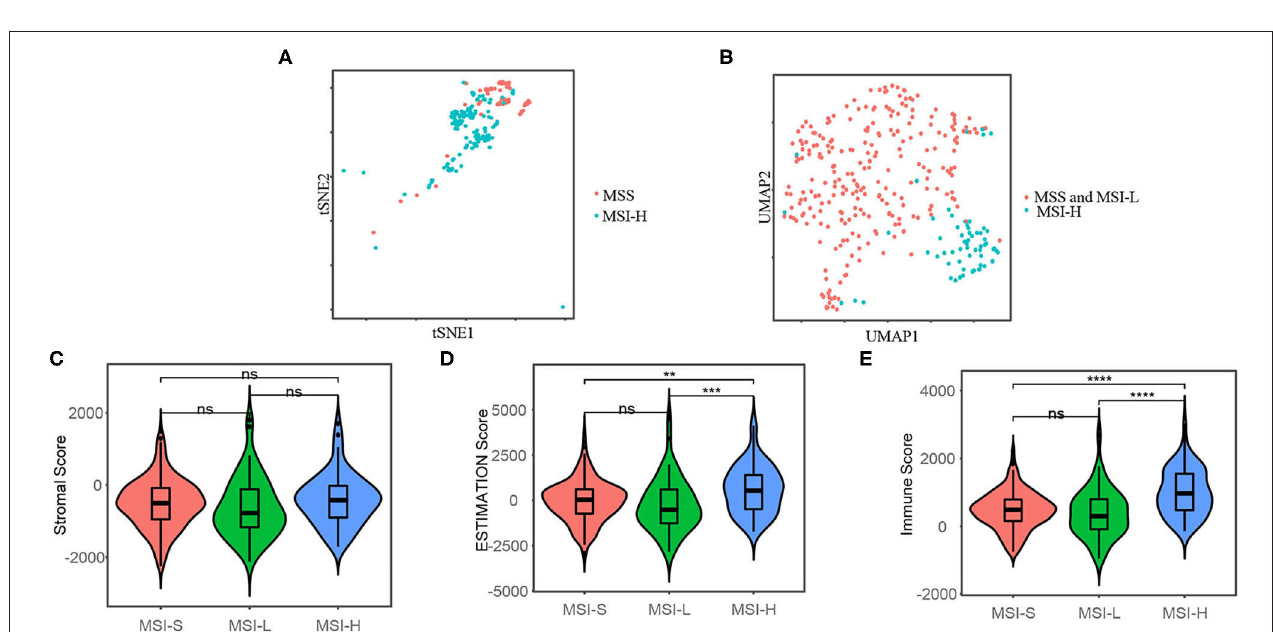
FIGURE 2 | t-distributed stochastic neighbor embedding (t-SNE) plot (A) shows that the microsatellite instability-high (MSI-H) and microsatellite stability (MSS) colon cancer cells are clustered differentially by single-cell RNA sequencing (RNA-seq) data from GSE146771 and uniform manifold approximation and projection (UMAP) plot (B) shows that the MSI-H and MSS/microsatellite instability-low (MSI-L) colon cancer samples are clustered differentially included in this study from the TCGA-COAD cohort. Stromal score (C) , the Estimation of STromal and Immune cells in MAlignant Tumors using Expression data (ESTIMATE) score (D) , and immune cell score (E) of the different microsatellite status, which represent the stromal cell fraction, tumor purity, and immune cell fraction of tumor samples, respectively. The Mann–Whitney U-test was applied for difference comparison between the two groups. The Mann–Whitney U-test ; ns: p > 0.05; * P < 0.05; ** P < 0.01; *** P < 0.001; **** P <